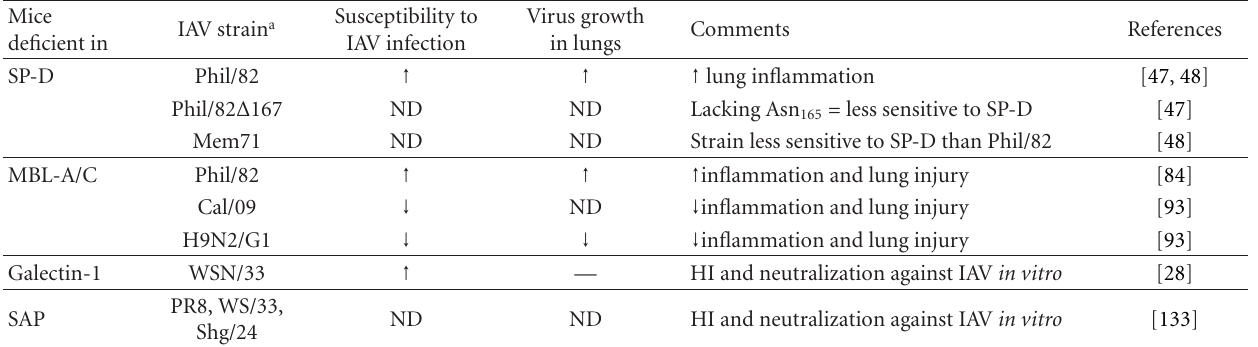
Table 3: Virulence of di ff erent IAVs in mice genetically deficient in particular animal